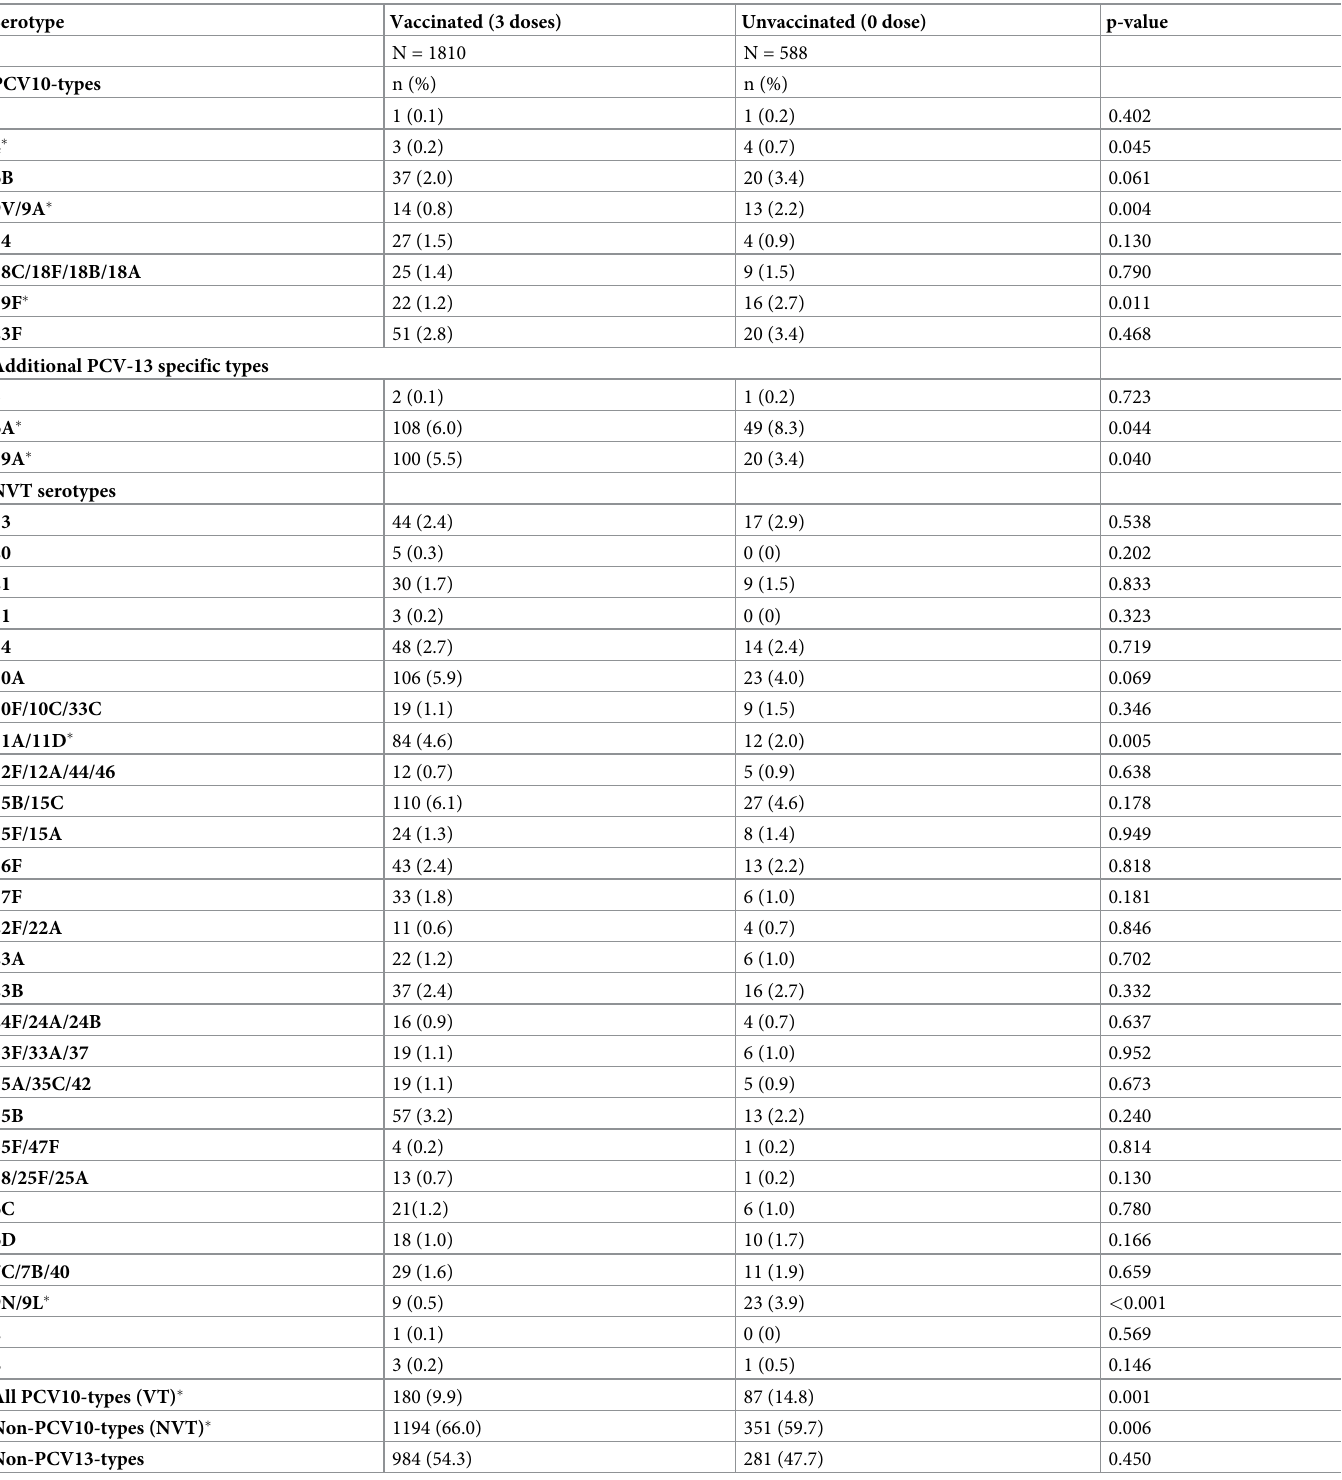
Table 2. Serotype-specific carriage rate by vaccination status.